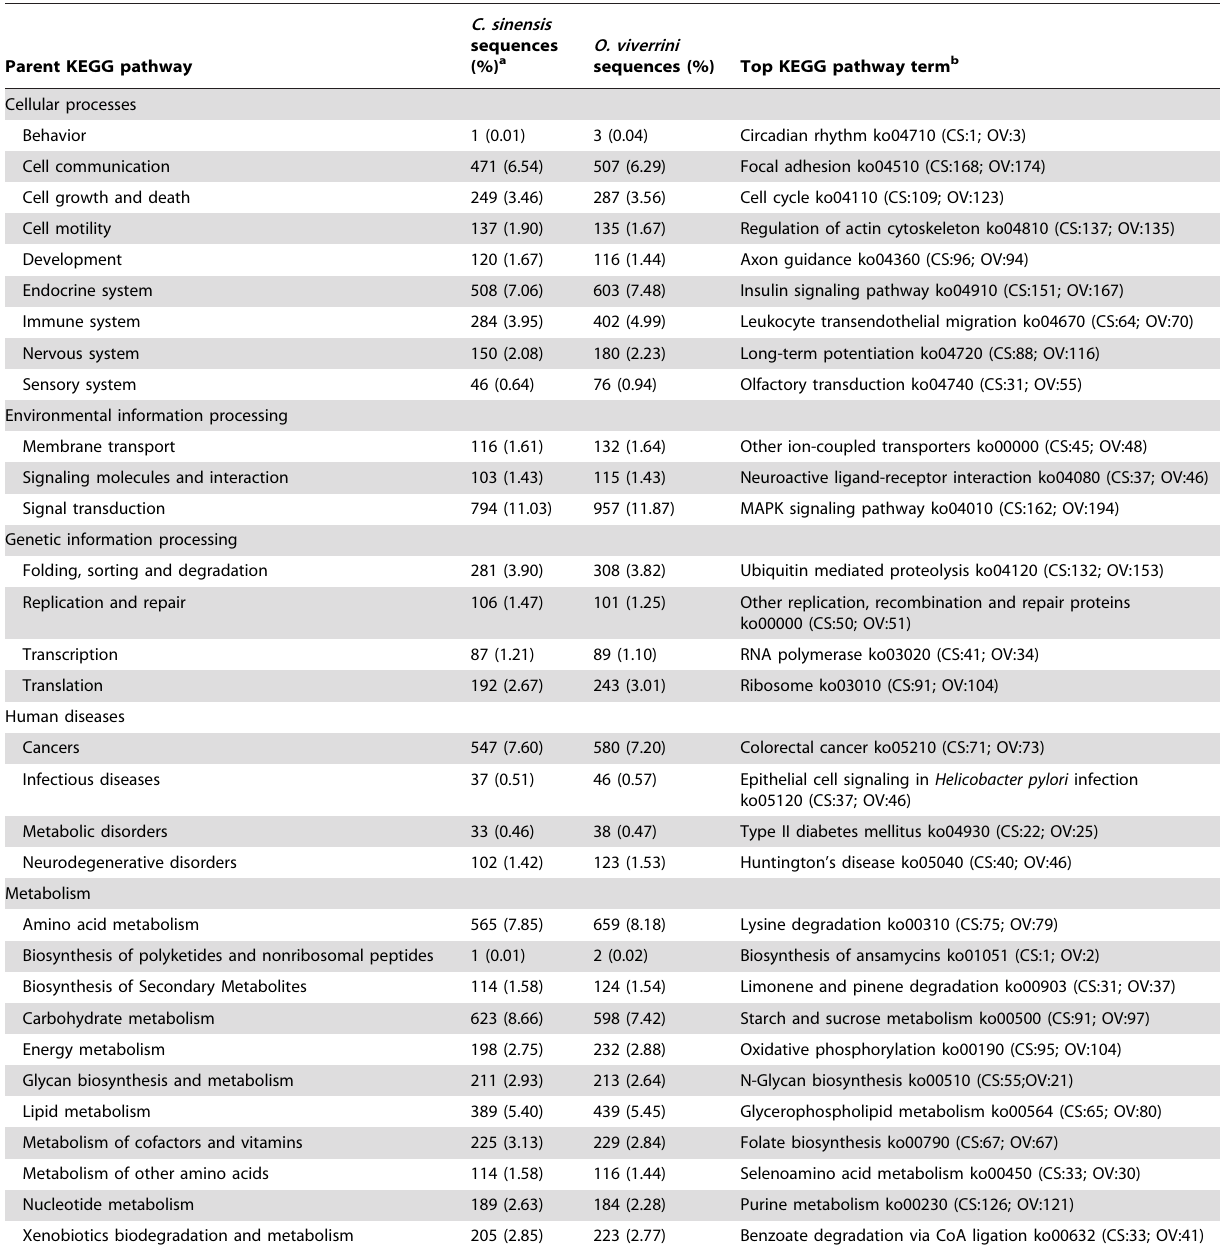
Table 7. Summary of biological key pathways predicted from amino acid sequences encoded in the transcriptome of the adult stage of each Clonorchis sinensis and Opisthorchis viverrini based on homology to annotated proteins in the Kyoto Encyclopedia of Genes and Genomes (KEGG) biological pathways